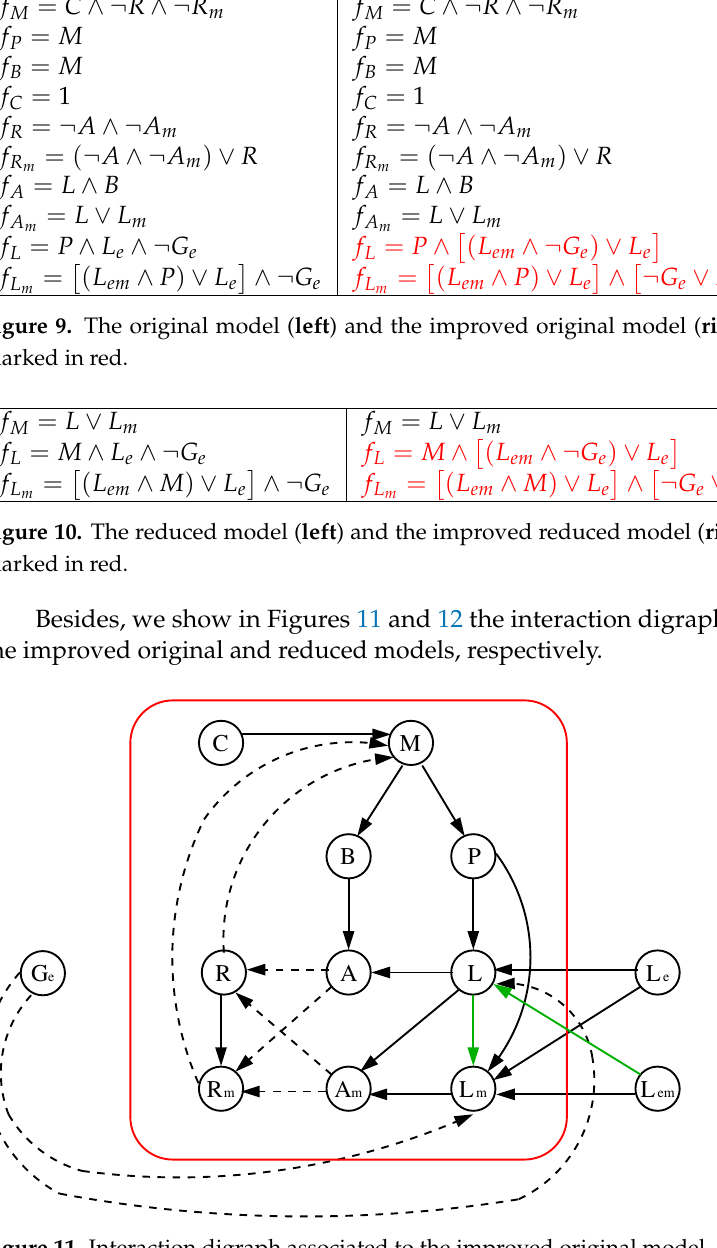
Figure 11. Interaction digraph associated to the improved original